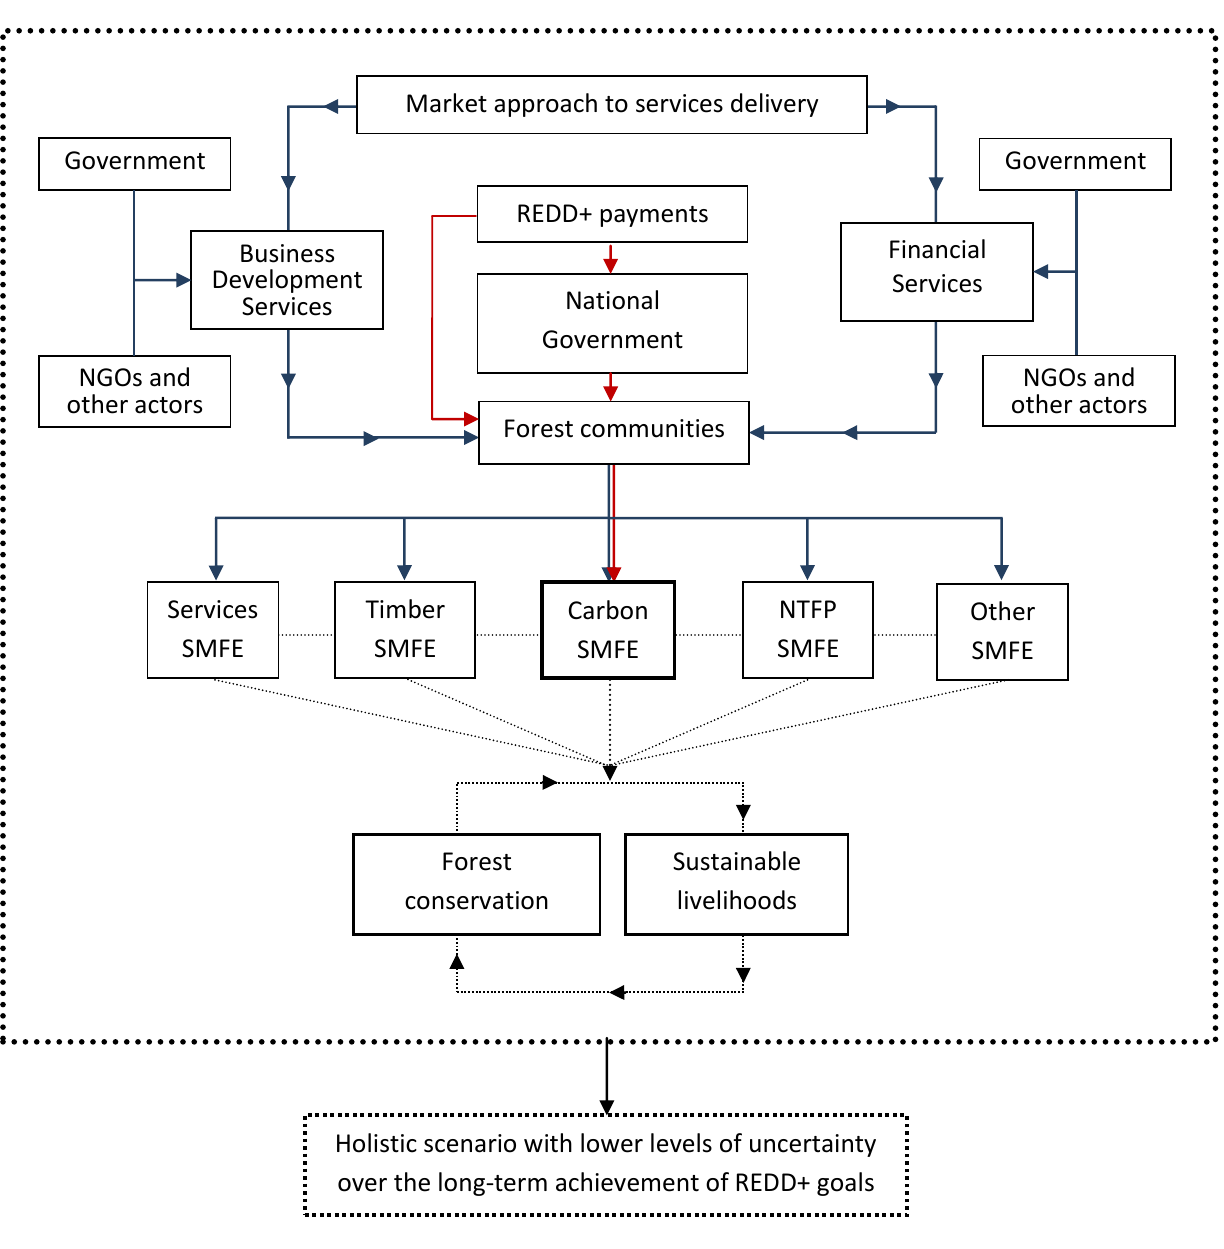
Figure 2. Possible Scenario 2—the proposed new model, with a business approach to promoting